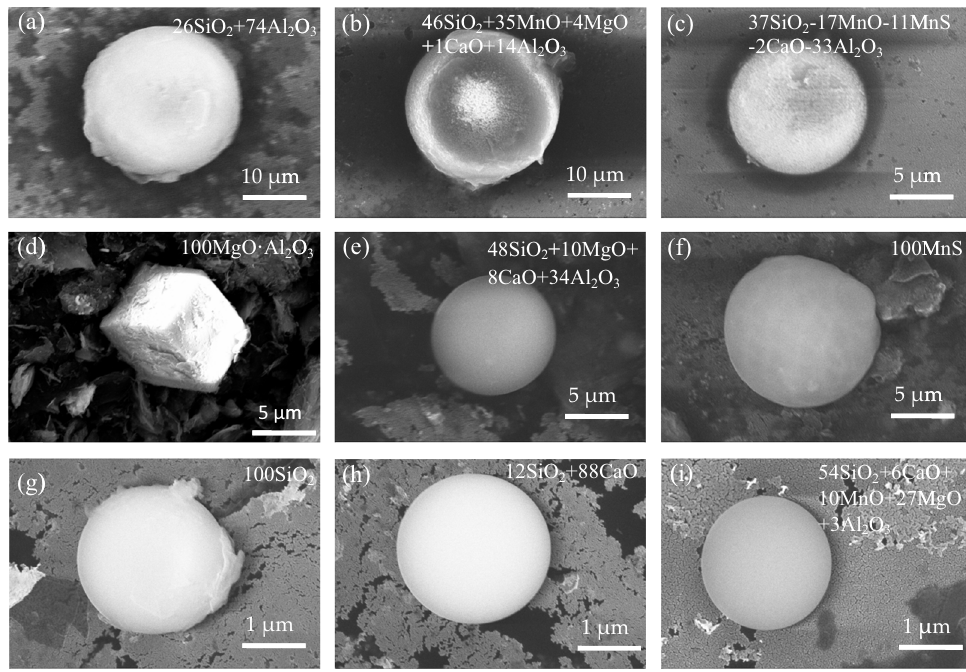
Figure 5: Typical inclusions in steel samples obtained using electrolysis: ( a – c ) Cru - A , ( d – f ) Cru - MA , and ( g – i ) Cru - MC .